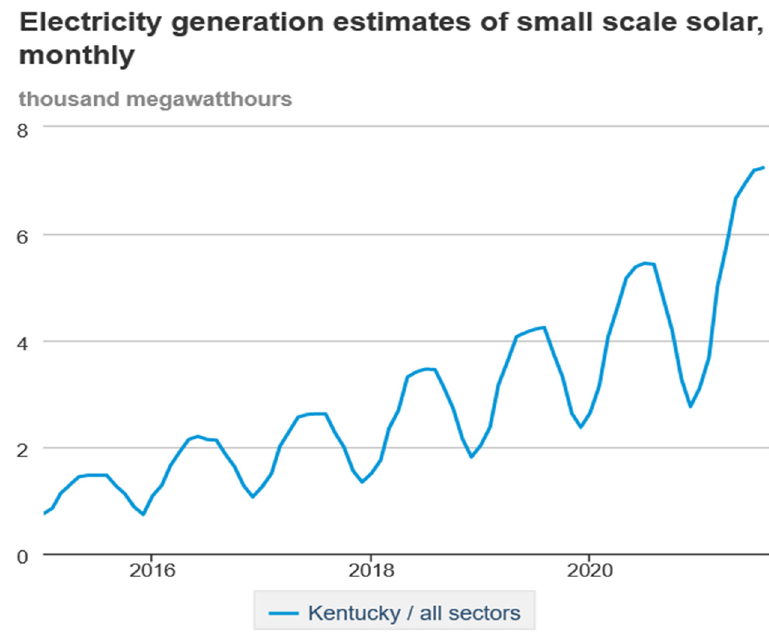
Figure 6. Electricity generation estimates for small scale solar in Kentucky [8]. In addition to this, businesses and farms have begun to have solar panels installed to reduce electricity costs. For example, the Hemphill Community Center claims their solar panels and their newly reduced electricity bill are the reason they were able to